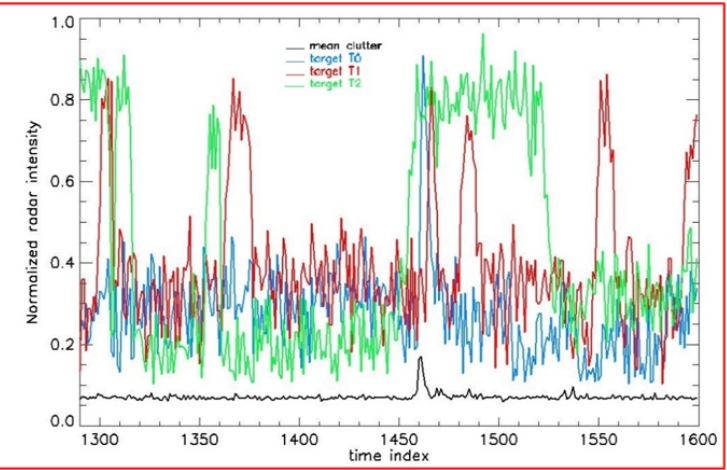
Figure 12. Radar intensities of the targets related to the third release . The high radar intensity values of targets T1 (red line) and T2 (green line) are due to